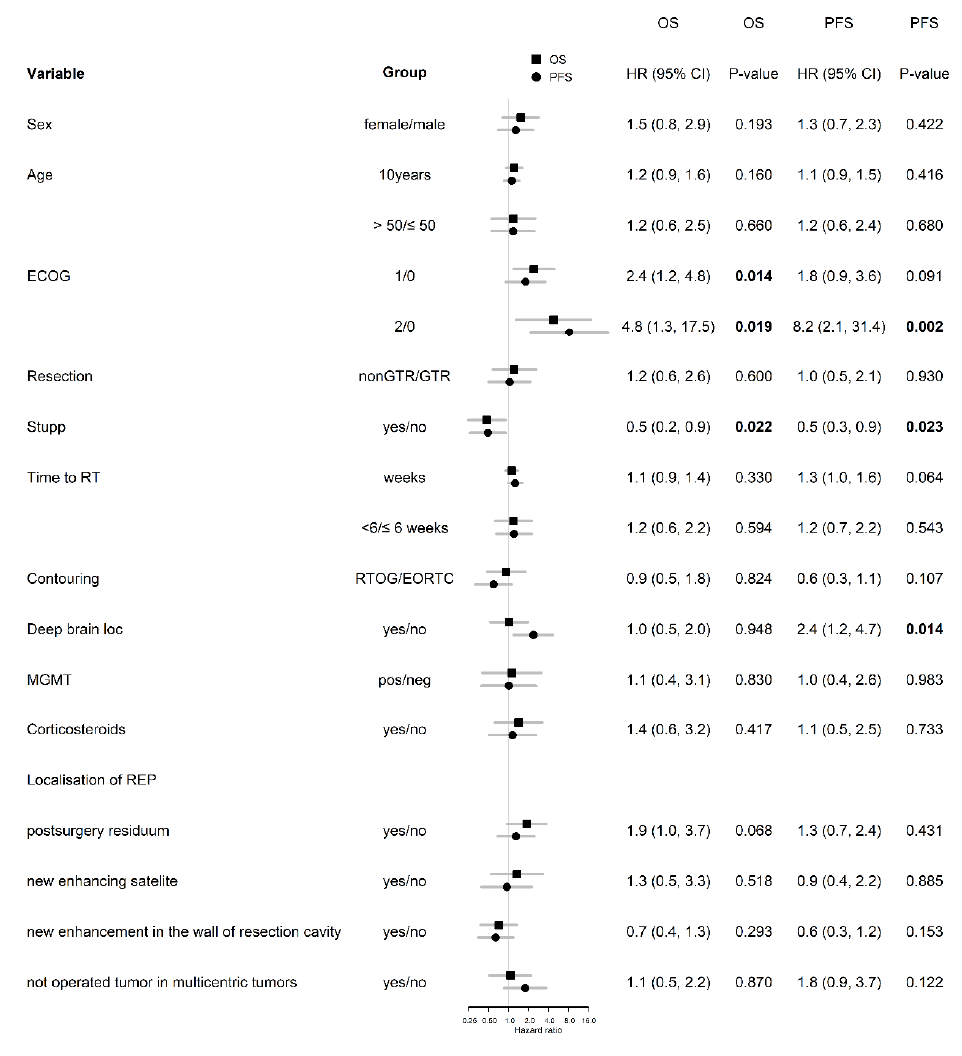
Figure 6. Univariable analysis in patients with REP. Number in bold are < 0.05. Table 4. Multivariable analysis in patients with REP.